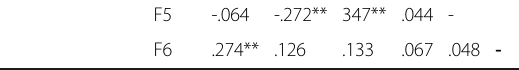
Brazilian version of the SCS-MS (Continued) F5 -.064 -.272** 347** .044 - F6 .274** .126 .133 .067 .048 - Note: F1 – Fairness; F2 - Order and discipline; F3 - Parent involvement; F4 - Sharing of resources; F5 - Student interpersonal relations; F6 - Student-teacher relations. In bold,